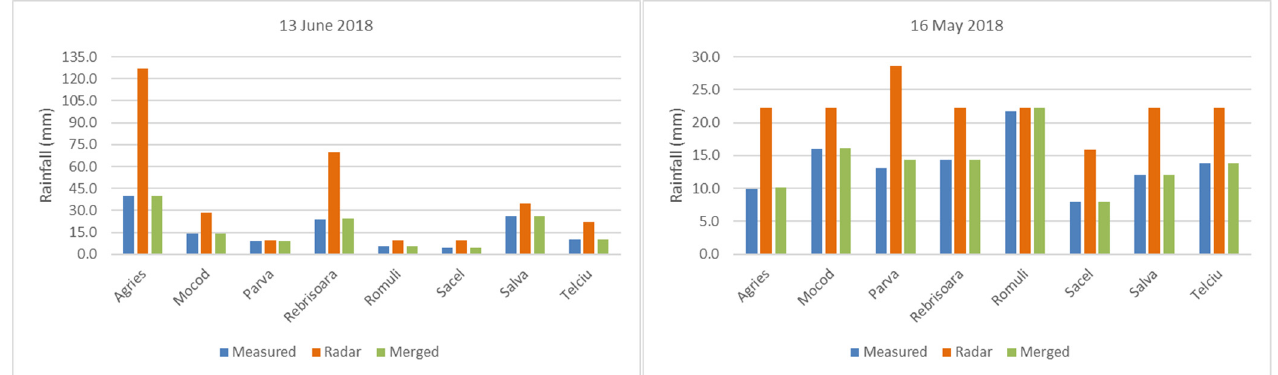
Figure 6. Frontal system comparative rainfall amounts.